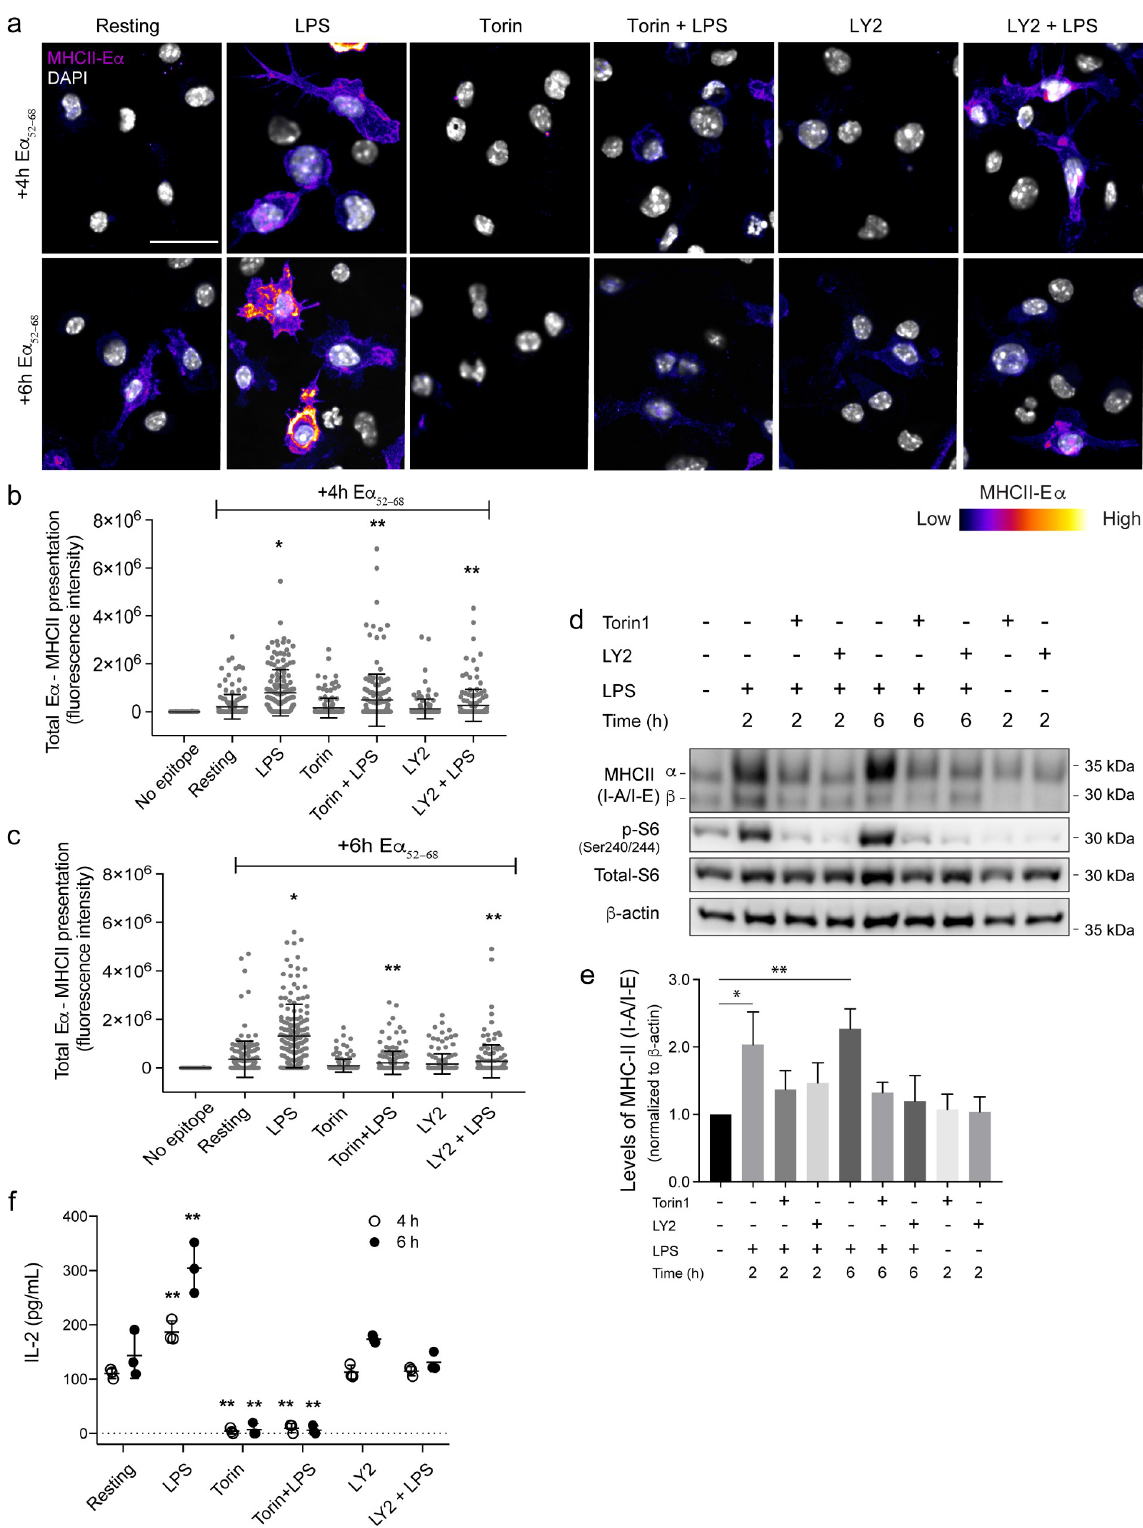
Fig 9. mTOR and S6K control E α 52–68 peptide presentation in activated BMDCs. BMDCs were incubated with E α 52–68 peptide for 4 or 6 h in the presence or absence LPS with or without torin1 and LY2584702. Cells were then fixed and stained with Y-Ae antibodies to detect I-A b